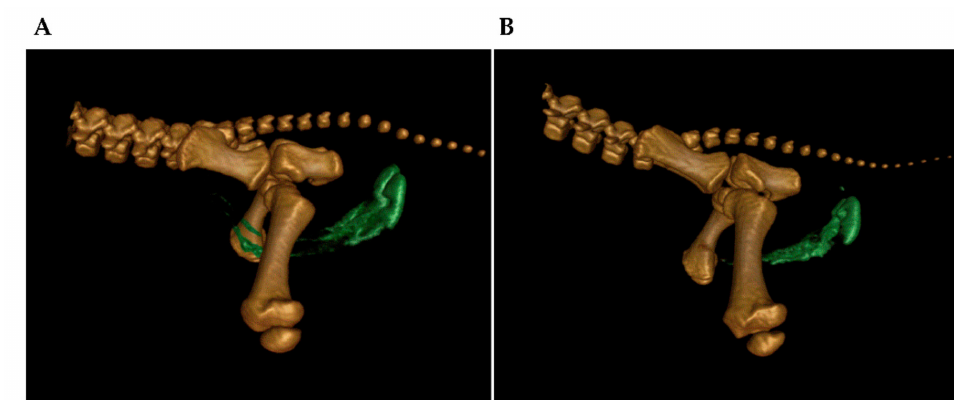
Figure A1. Distribution of the lidocaine/contrast medium mixture 20 min after injection using the one-step F and two-step methods. Exemplary three-dimensional reconstruction of a piglet injected using the one-step F ( A ) and a piglet injected using the two-step method ( B ). Bone structures such as parts of the spine, pelvis and femur are colored brown. The injected lidocaine/contrast agent mixture is colored